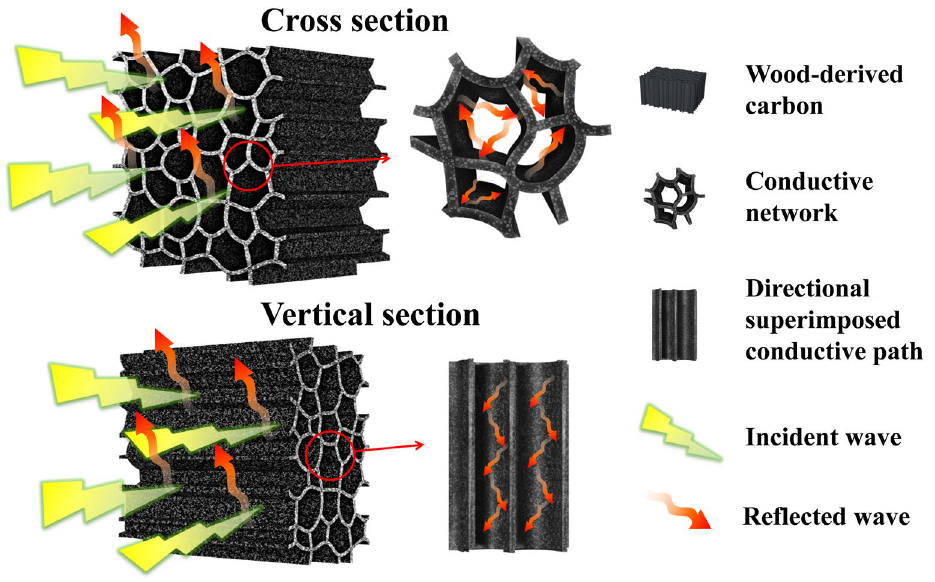
Figure 7. Schematic diagram of EMI shielding mechanism of WC materials.